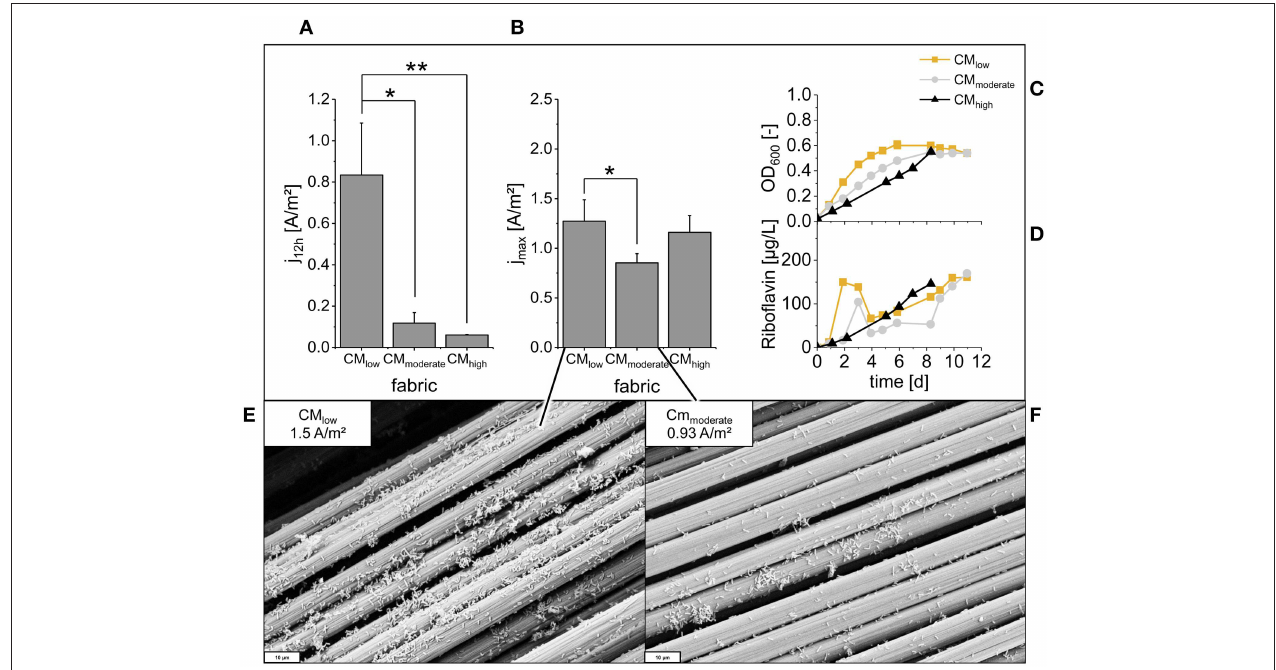
FIGURE 6 | (A) Startup current density j 12h (B) , maximum current densities j max (both normalized to 2D projected surface area) (C) , planktonic growth, and (D) riboflavin production achieved with fabric electrodes made from continuous multifilament (CM) with increasing carbon contents (low, moderate, high). (A,B) Are average values and standard deviations from triplicates (duplicates for CM high ), (C,D) are representative single experiments. Single/double asterisks mark significance levels of p < 0.05 and p < 0.01 (two-sampled t -test). (E,F) : SEM images of the of CM low /CM moderate electrodes, which were taken after 13 days from reactors sharing identical inocula; scale bars = 10 µ m. Current density values displayed in images (E,F) correspond to the sampling time point (end of